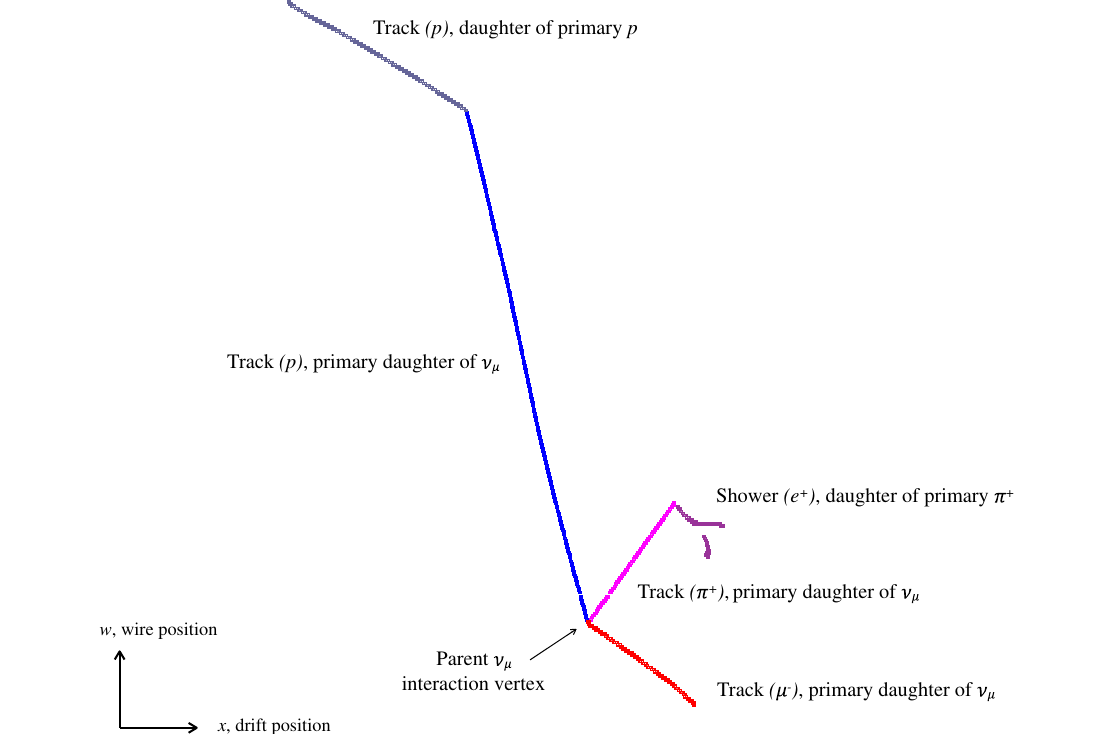
decays into a μ + , which rapidly decays into a e + and is reconstructed as a shower-like secondary daughter particle. The proton scatters off a nucleus, resulting in a track-like secondary daughter particle. Pan- dora identifies each particle as track-like or shower-like and the explicit particle types were identified using information from the